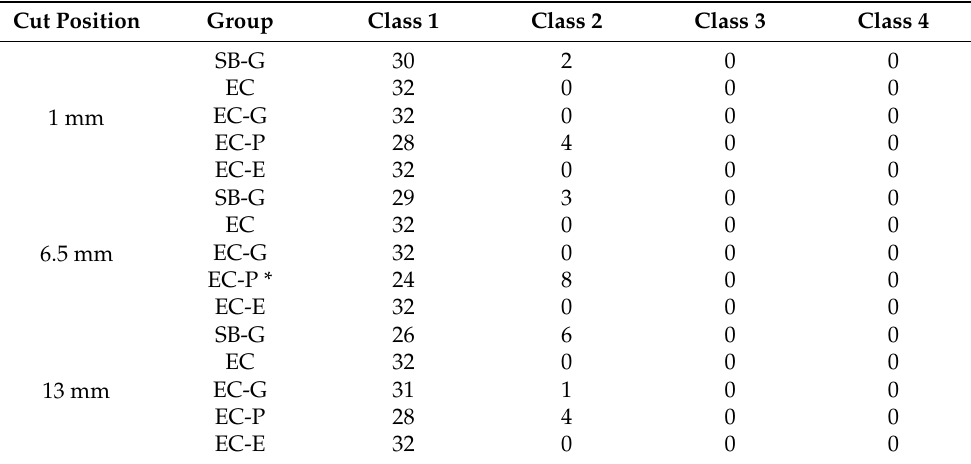
Table 2. Microleakage results at each cut position in the adhesive model.